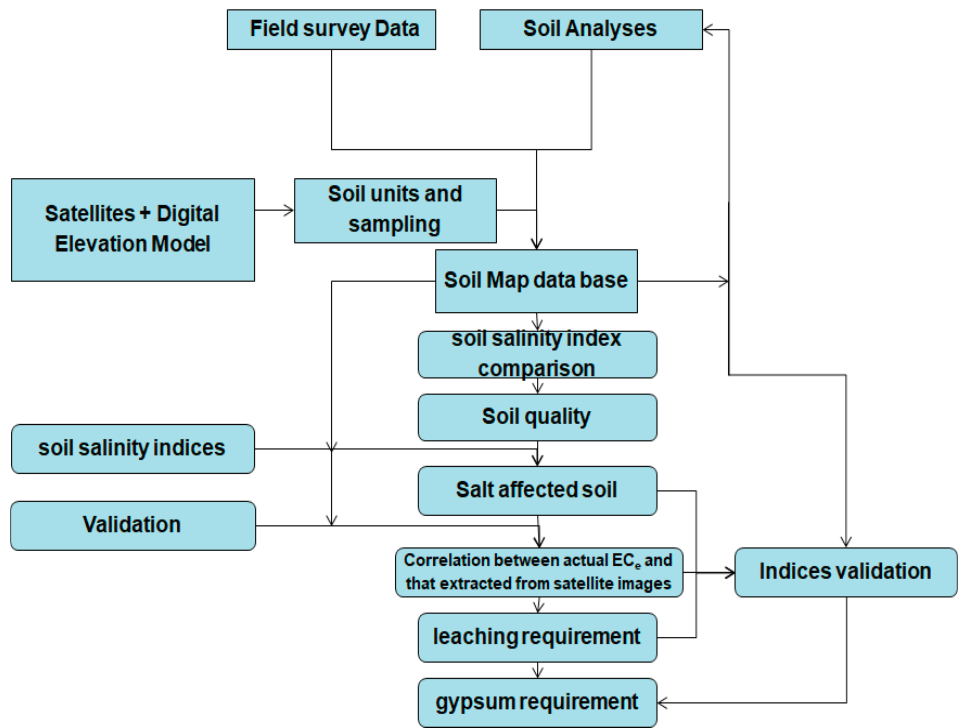
Figure 3. The workflow of saline soil amelioration using Landsat 8 OLI image.